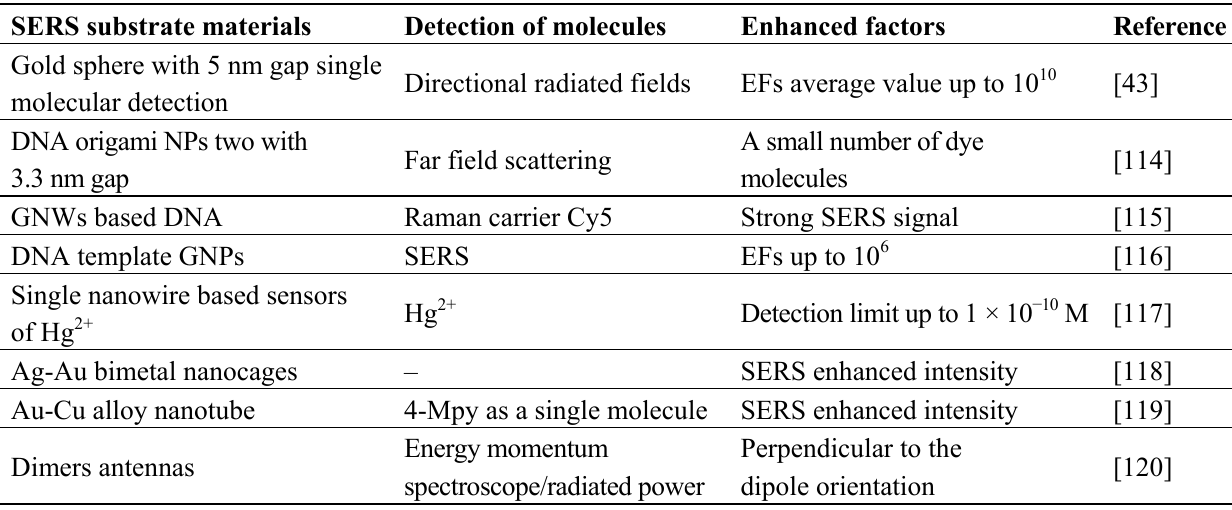
Table 8. List of the recent studies on